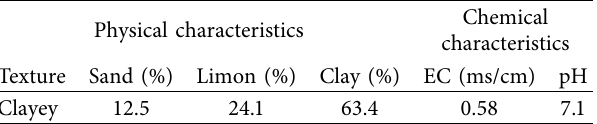
Figure 2: Treatment of saffron corms by different concentrations of GA Table 1: Physicochemical characteristics of the soil (0–30 cm depth).